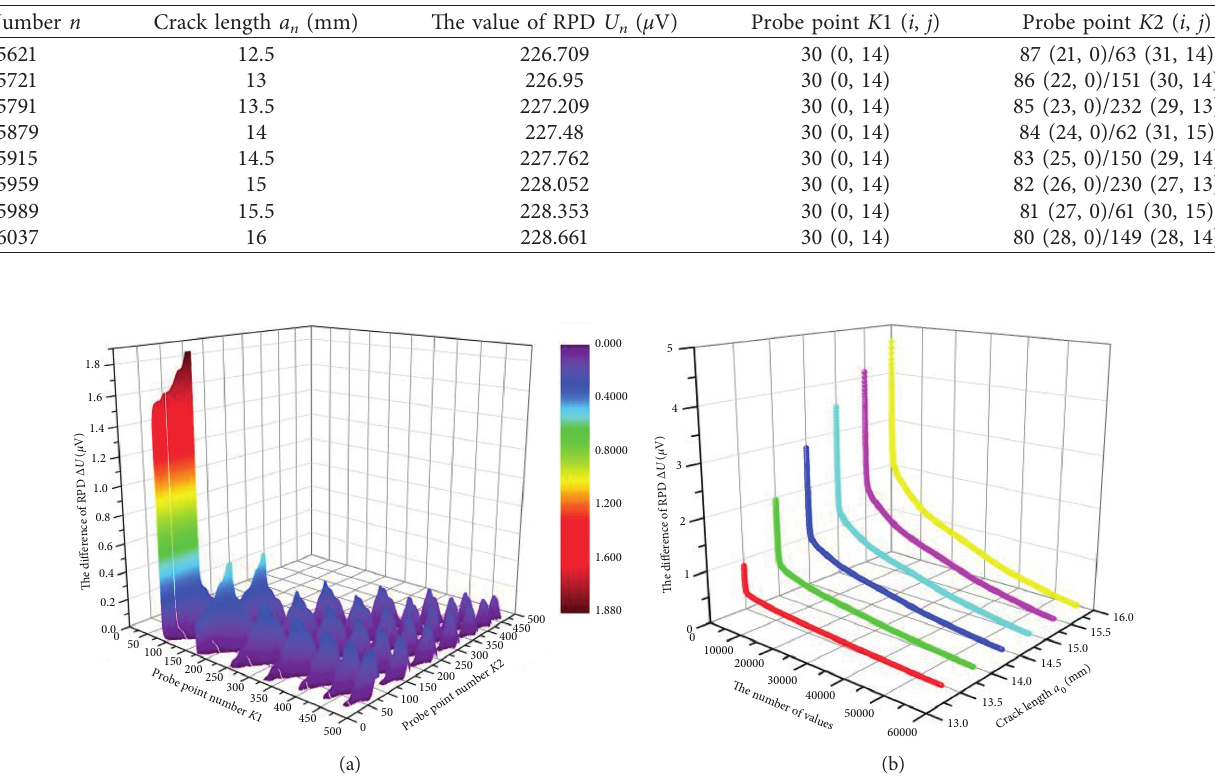
Figure 12: The optimization of crack independence with GA. (a) The difference between the RPD before optimization. (b) The difference between the RPD after